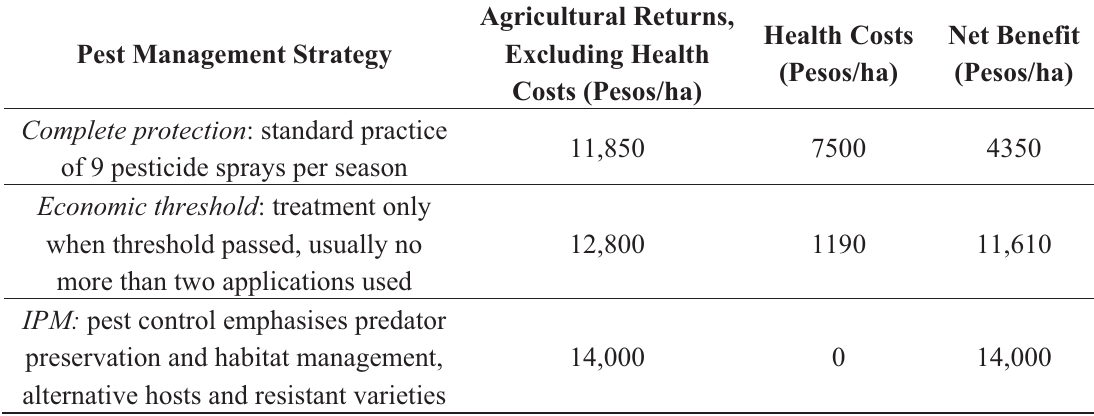
Table 4. Benefits and health costs of three pest management strategies in irrigated rice,